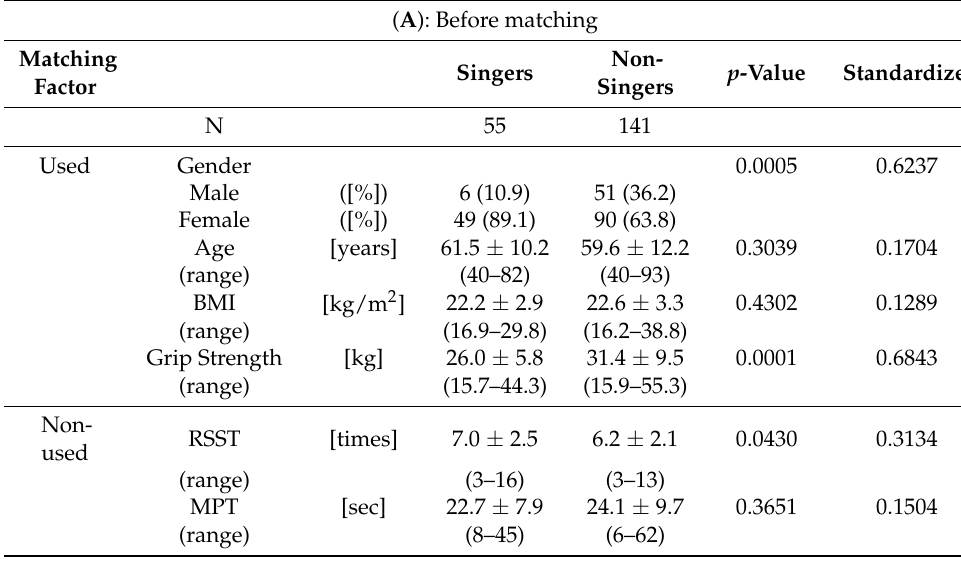
Table 3. Covariate imbalance prior to matching and matched